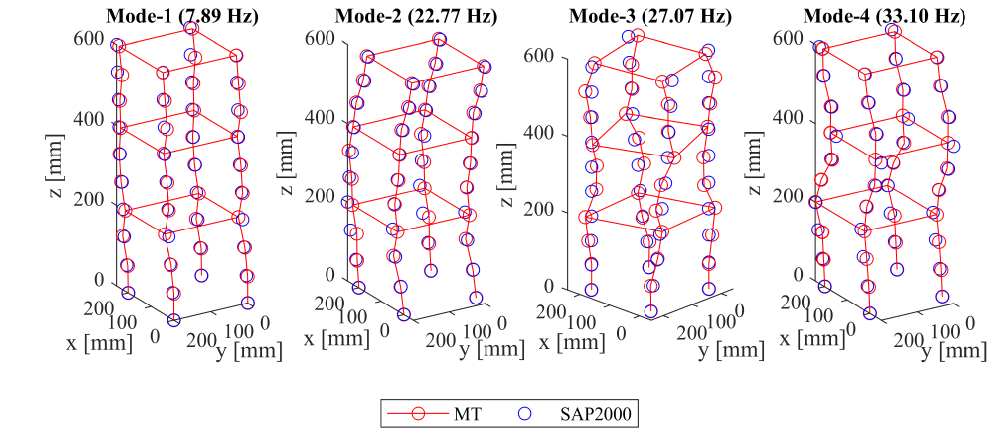
Figure 11. Comparison between the normalized mode shapes obtained via SAP2000 and the operational deflection shapes via 3D-MT using a “fine” grid (scaled for better